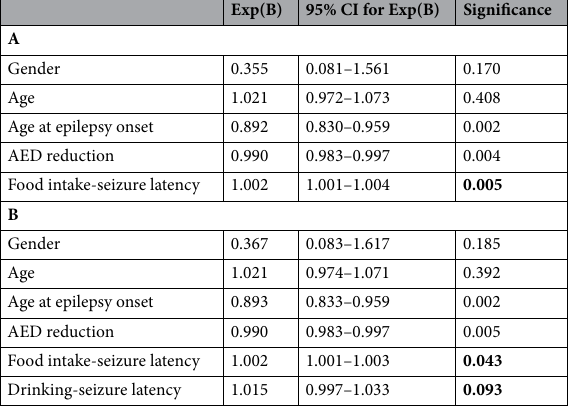
Table 3. Results of the generalized estimating equations model regarding the effect of eating—food intake- seizure and drinking-seizure latency (Method C). AED : antiepileptic drug; CI : confidence interval.